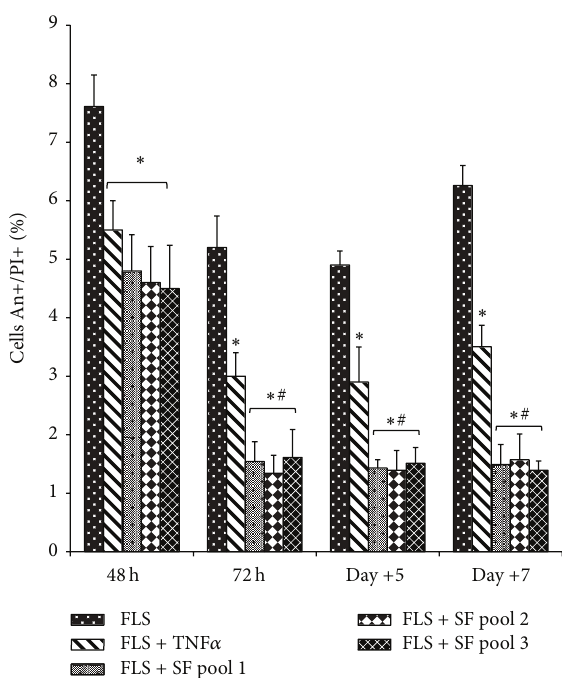
Figure 2: Effects of synovial fluid and TNF 𝛼 on spontaneous apop- tosisofRAfibroblast-likesynovialcells.RAsynovialfibroblastswere cultured in the presence of TNF 𝛼 (25ng/mL), three SF pools (1: 8 dilutioninculturemedium),ormediumalone.Apoptosiswasevalu- ated at the indicated times. Cells were stained with annexin V-FITC and propidium iodide and analysed by flow cytometry. Apoptotic cells were measured as the percentage of annexin V-positive/PI- positive cells. Results are expressed as the mean percentage ± SD from four individual experiments. ∗ 𝑃 < 0.05 versus FLS; # 𝑃 < 0.05 versus FLS + TNF 𝛼 .